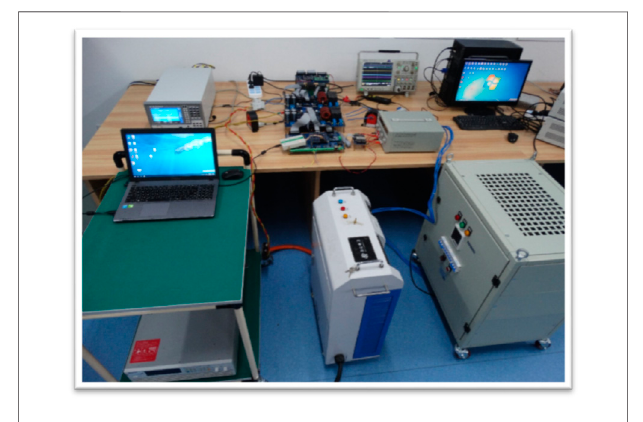
FIGURE 7 | Experimental